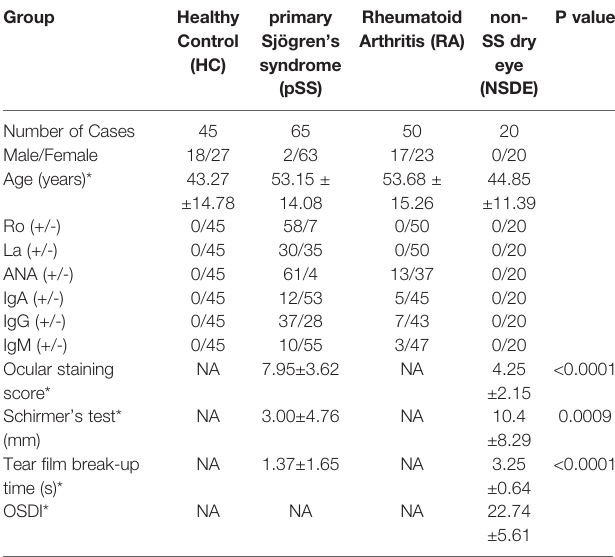
TABLE 1 | Basic clinical characteristics of study groups.